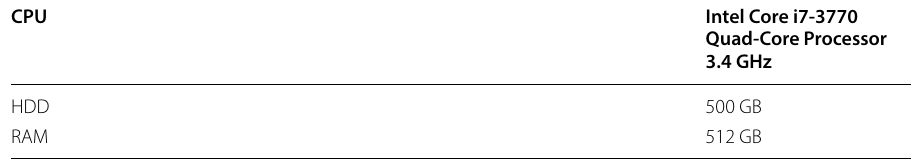
Table 13 Reducer and rule generation node